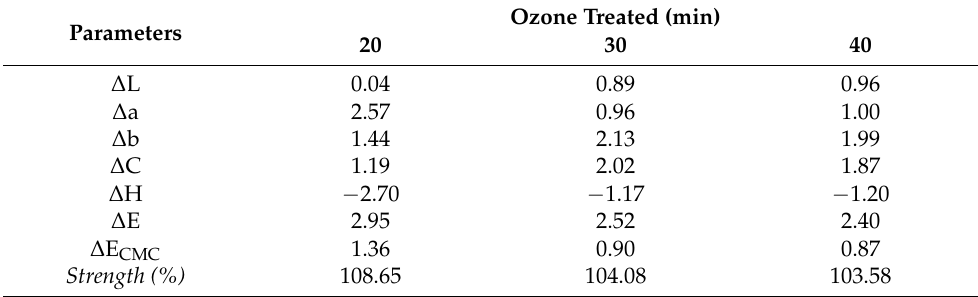
Table 3. Color assessment of ozone-treated polyester fabrics compared to untreated fabric.